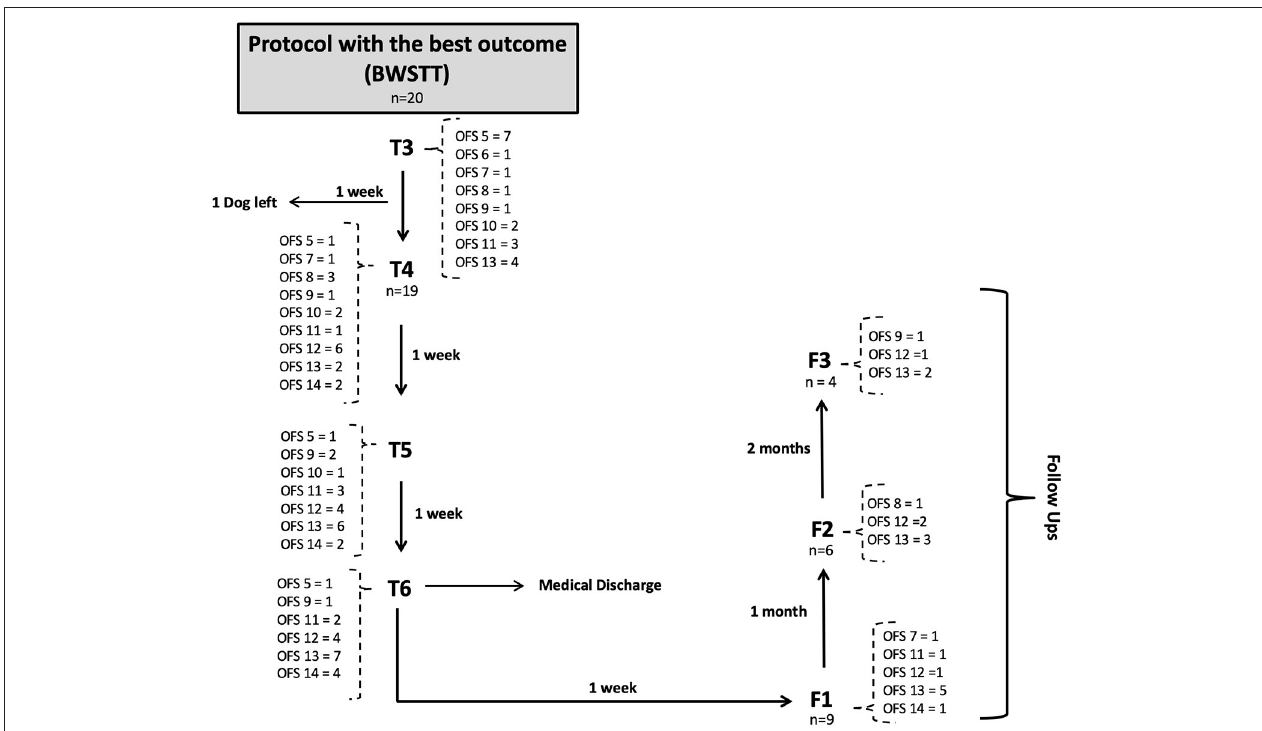
FIGURE 10 | Flow diagram describing the neurologic evolution of the 22 dogs. FNR, Functional neurorehabilitation; T4, T5, T6,After 3,4 and 5 weeks of the same protocol; F1, F2, F3, Follow-up after 1 week, 1 and 2 months; BWSTT, Body-weight supported treadmill training; COGI, conventional overground intervention.